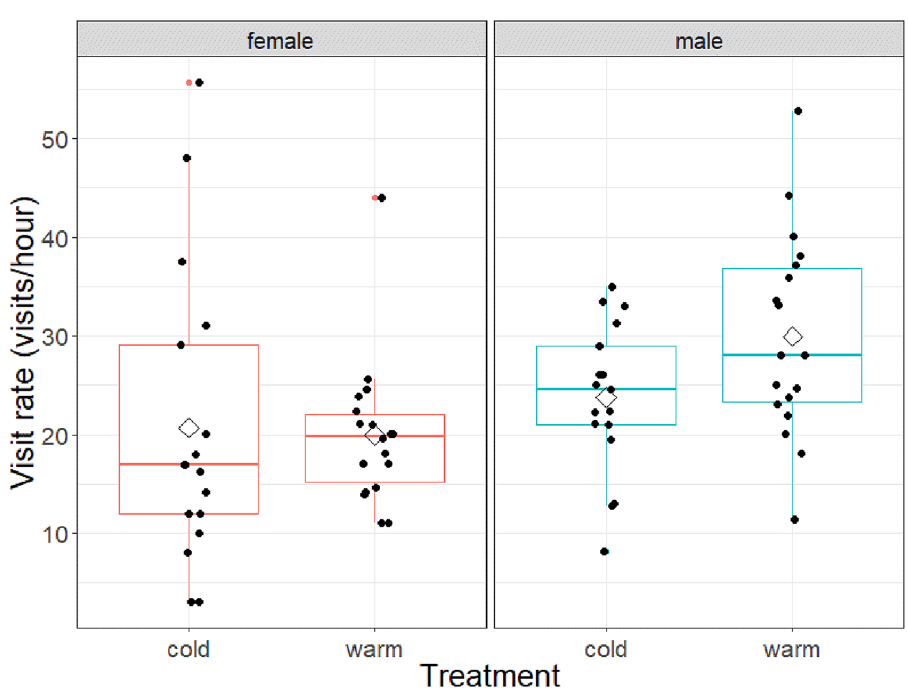
Figure 2. The effect of temperature manipulation on parental nest visit rates (number of visits/hour) for both female and male parents when nestlings are 4 days old. Boxplot distribution (red), mean (diamond) and data points (black) are presented. Females and males were analysed separately. Mean ± SE for females of cold treatment: 20.7 ± 3.6 Visits per hour; females of warm treatment: 20 ± 1.8 visits/hour; males of cold treatment: 23.7 ± 1.8 visits/hour; males of warm treatment: 30 ± 2.4